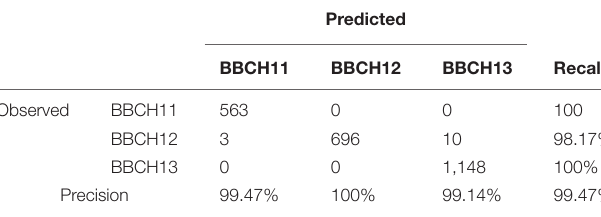
TABLE 7 | Confusion matrix for EfficientnetB4 evaluated on the test